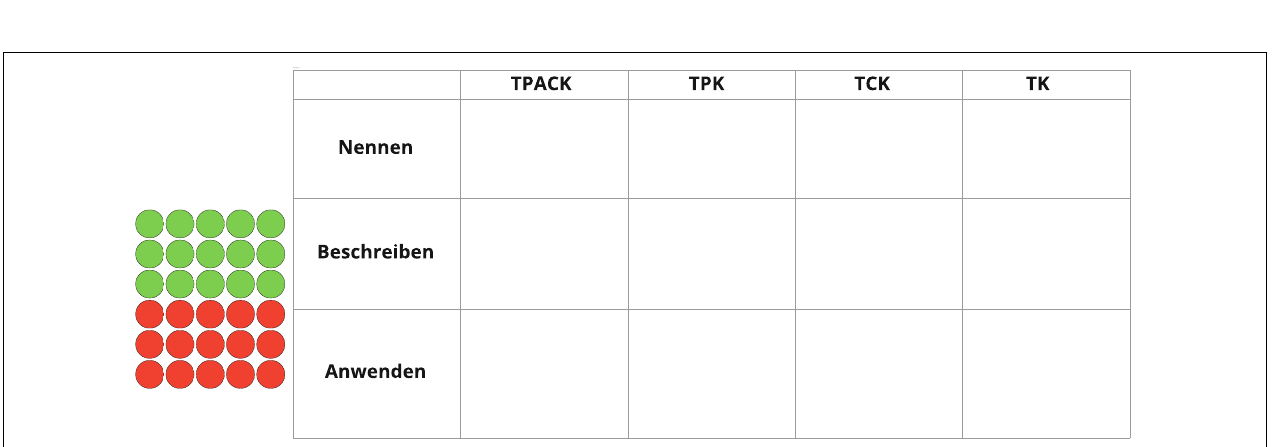
FIGURE 3 | Excerpt from the collaborative online board, with the instructional material for assessing the sub-structuring of competency areas into knowledge facets according to the TPACK model (e.g., Koehler et al., 2013) and the DPaCK model (Huwer et al., 2019a,b) and into competency levels Nennen [Name], Beschreiben [Describe], and Anwenden [Use/apply]. The colored circles can be dragged into the table to mark whether a field should be taken over (green) or not (red).